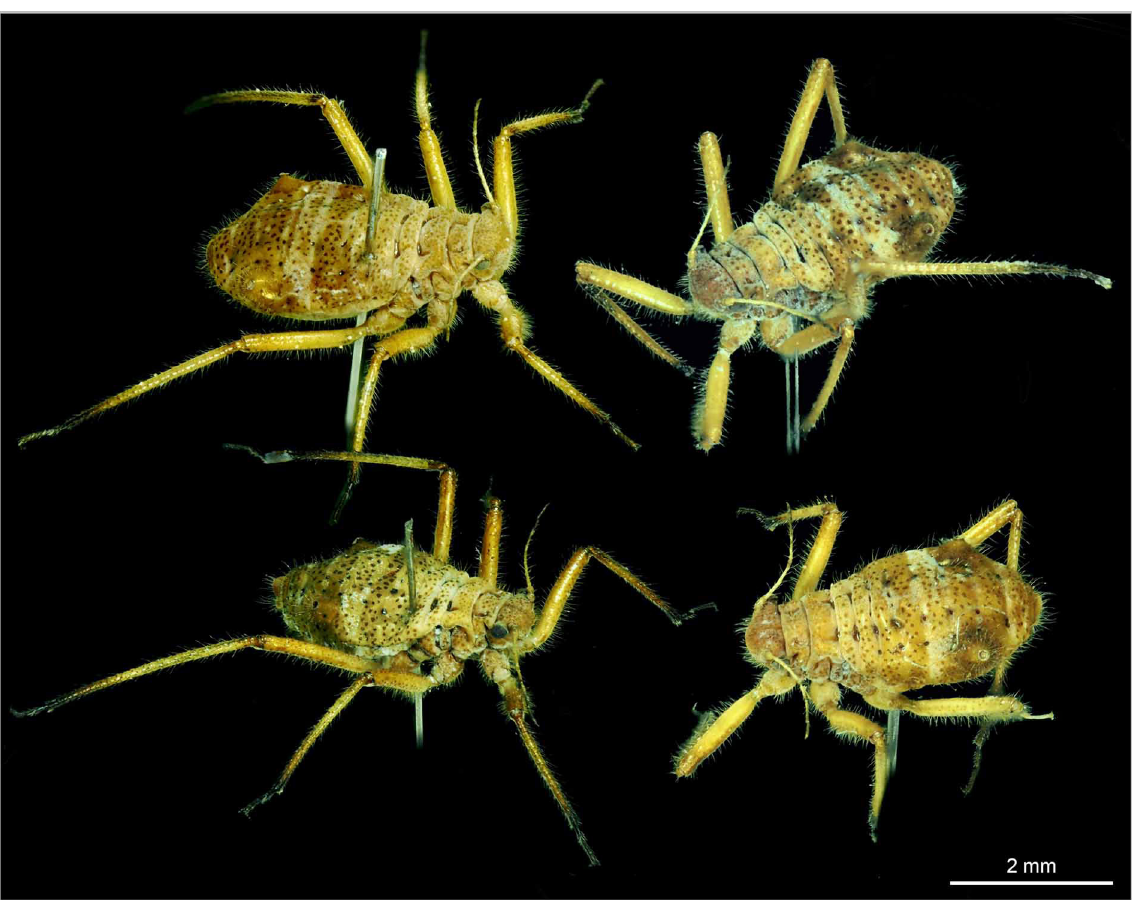
Fig. 100. Cinara (Cinara) pilosa (Zetterstedt, 1840). Apterae (freeze-dried